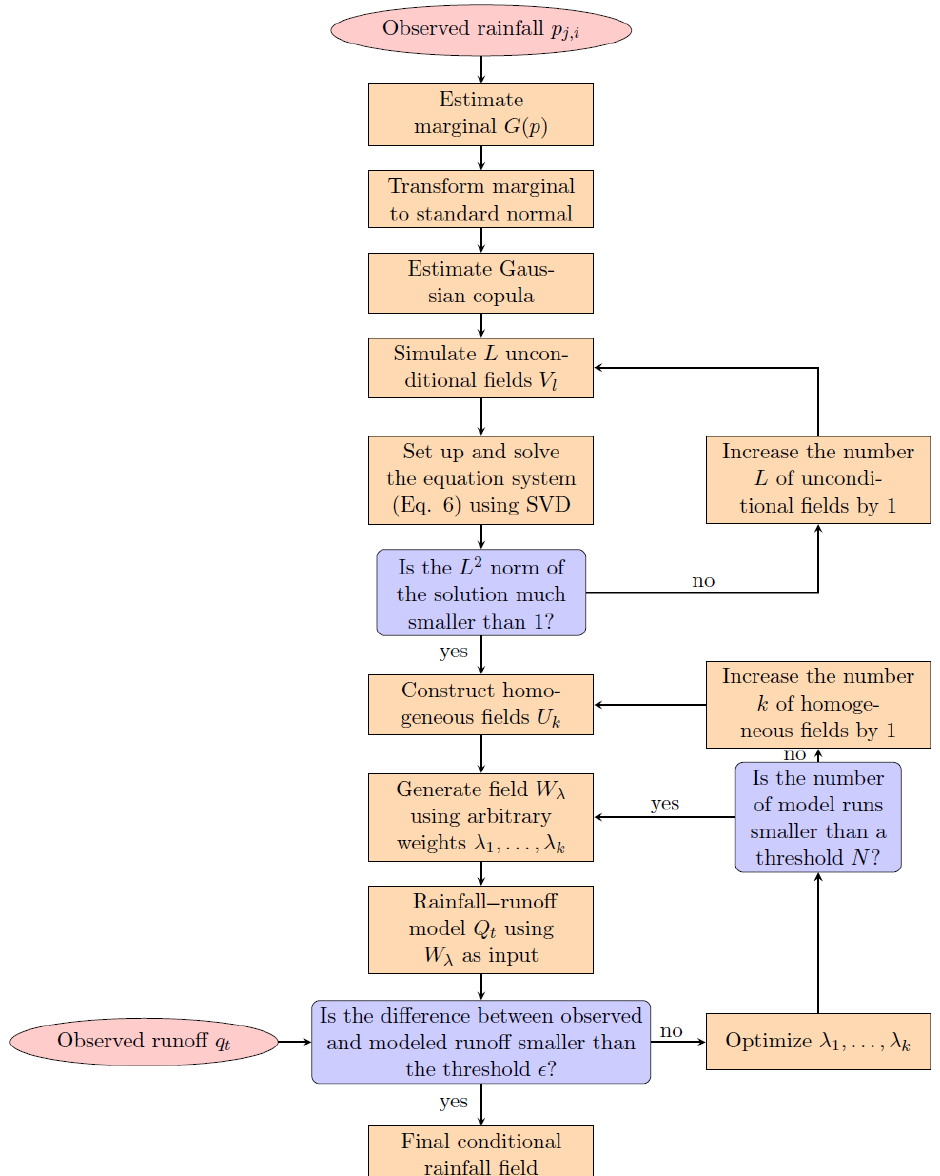
Figure 1. Flowchart of the Random Mixing algorithm for inverse hydrologic modelling.